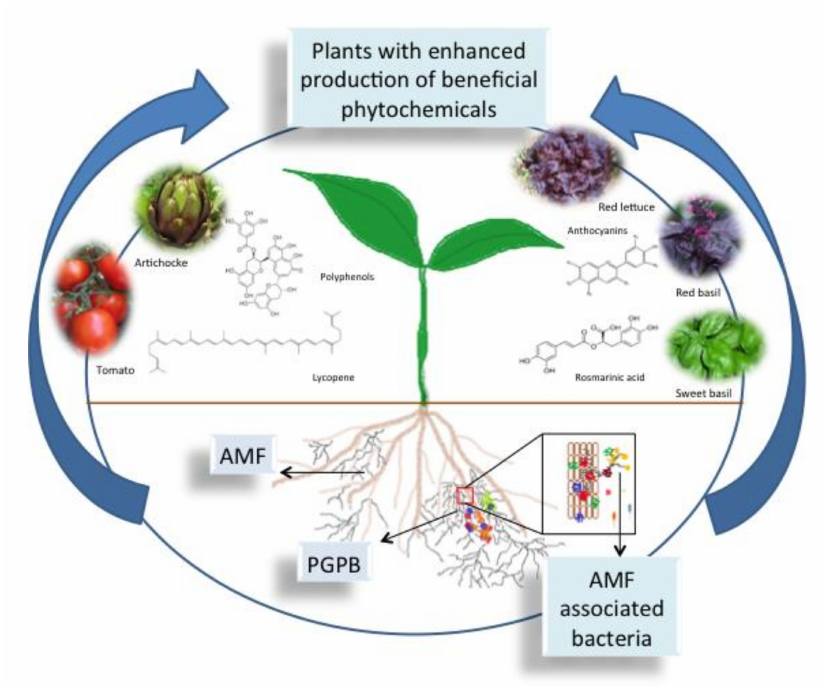
Figure 1. Schematic drawing representing the e ff ects of di ff erent beneficial soil microbial communities on plant production of health-promoting phytochemicals. AMF, arbuscular mycorrhizal fungi; PGPB, plant growth promoting